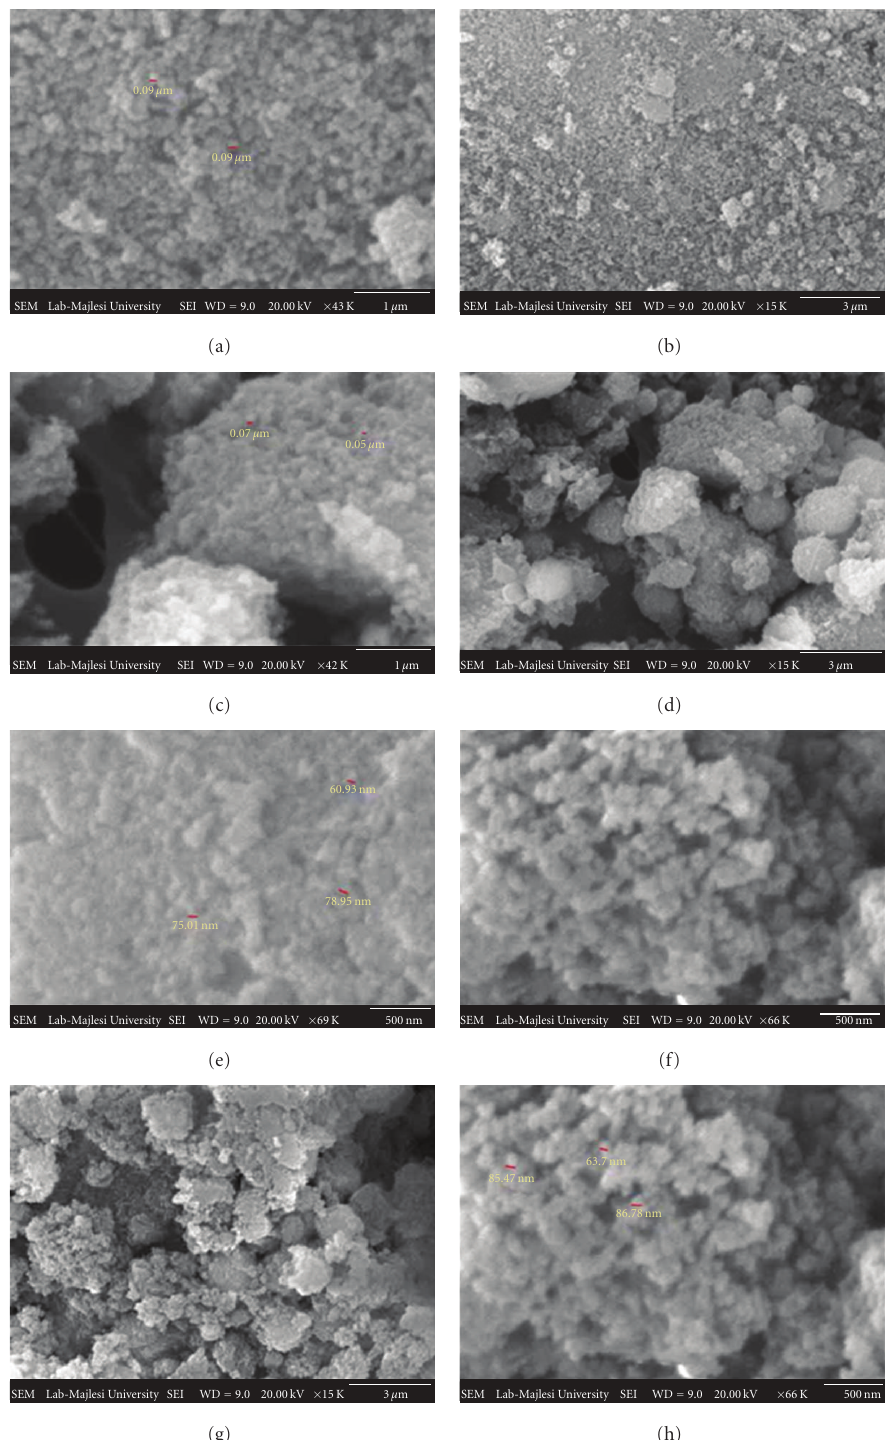
Figure 5: SEM images of (a, b) the NCY, (c–e) Fe-NCY, and (f–h) Fe-OP-NCY samples. photocatalyst leads to the disappearance of the